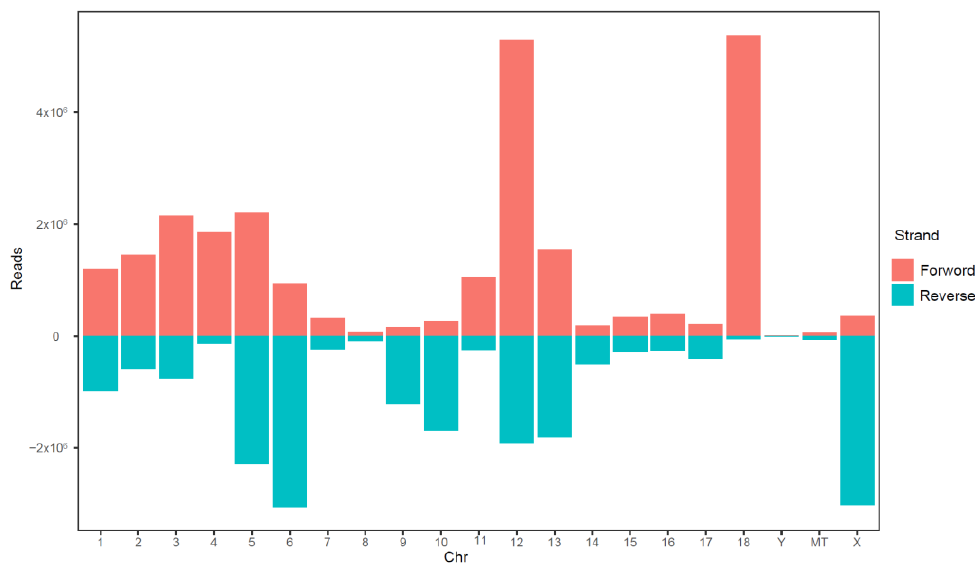
Figure 5. Distribution of miRNA coding sequences on positive and negative DNA strands. The abscissa represents chromosomal position, and the ordinate represents reads count.